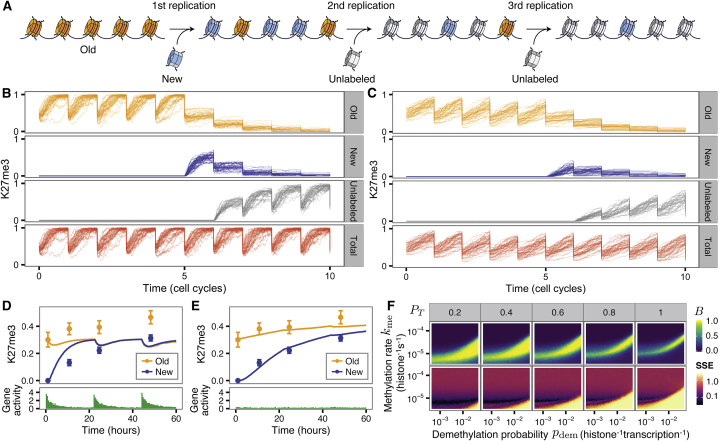
Fitting the Model to Experiments(A) Schematic of SILAC experiment: old histones (yellow) diluted by incorporation of new histones (blue) at first DNA replication. Chromatin from this replication is followed through two subsequent replications, during which both old and new histones are diluted by incorporation of unlabeled histones.(B and C) Forty over-plotted trajectories from simulated SILAC experiment. Plots show levels of K27me3-marked old, new, unlabeled, and total H3. Simulations initialized in the uniform me3 state were equilibrated for six cell cycles (five shown) before introducing new histones. (B) The slowest bistable model with PT = 1 (kme = 3 × 10−5 histone−1 s−1, pdem = 0.02 histone−1 transcription−1); (C) the best-fit model with PT = 1/3 (kme = 8 × 10−6 histone−1 s−1, pdem = 0.004 histone−1 transcription−1). Best-fit kme obtained by minimizing the sum of squared errors (SSE) between simulated and experimental SILAC data.(D and E). K27me3 levels on old and new H3 as a proportion of total old and new H3 incorporated, respectively. Points show experimental data from (Alabert et al., 2015), error bars: SEM (n = 3). Solid lines in (D) and (E) correspond to model simulations shown in (B) and (C), respectively. Results averaged over 1,000 simulations and normalized so that simulated mean cell-cycle end value of H3K27me3 is equal to the experimental mean initial level on old H3 (STAR Methods). Gene activity measured as number of transcription events per 30 min interval.(F) Heatmap showing bistability measure, B (top panel) and SSE (bottom panel). Each panel shows B and SSE as a function of kme and pdem, for PT shown in panel labels. B calculated from 150 simulations initialized in each of the uniform me0 or me3 states, simulated for 20 cell cycles for each parameter set. SSE calculated from 300 SILAC simulations for each parameter set. Simulations in (A)–(F) with fmax = 40fmin and pex = 10−3 histone−1 transcription−1, with other parameters as in Figure 1D.